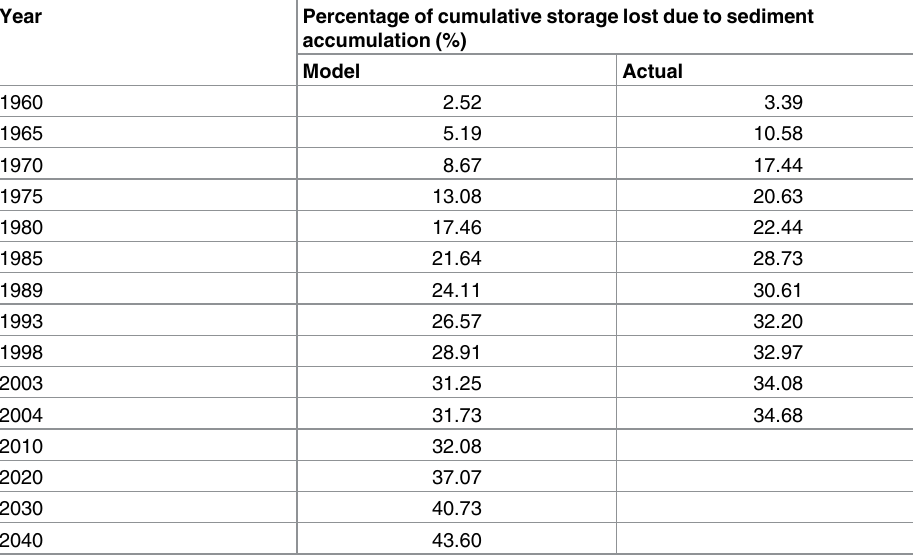
Table 2. Comparison of storage lost storage due to